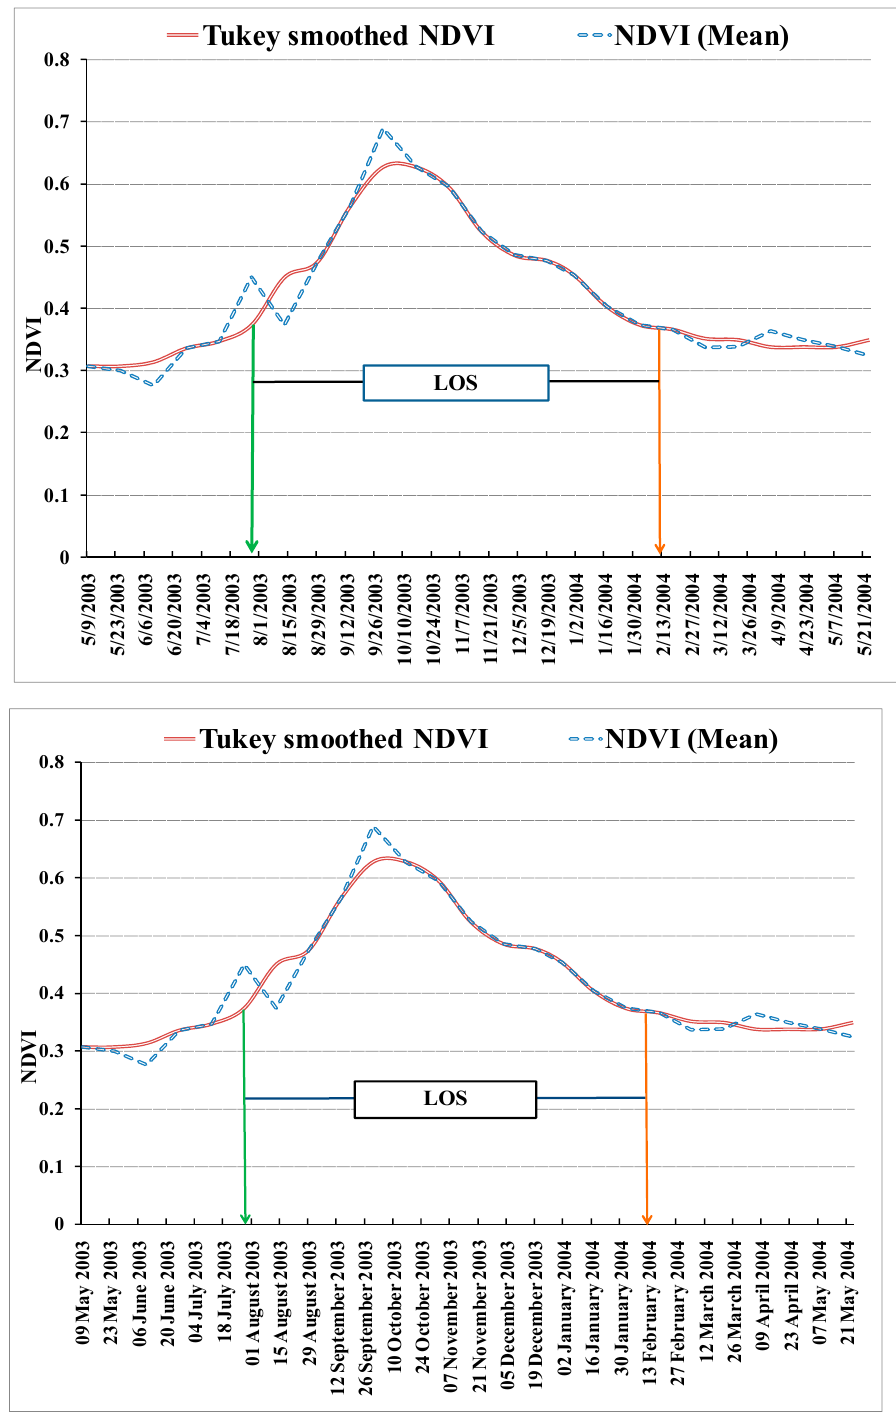
Figure 12. Raw MODIS NDVI and TS-smoothed reconstructed NDVI time series of year 2003–2004 for derivation of length of the season in Tectona grandis indicated between green and orange arrows.